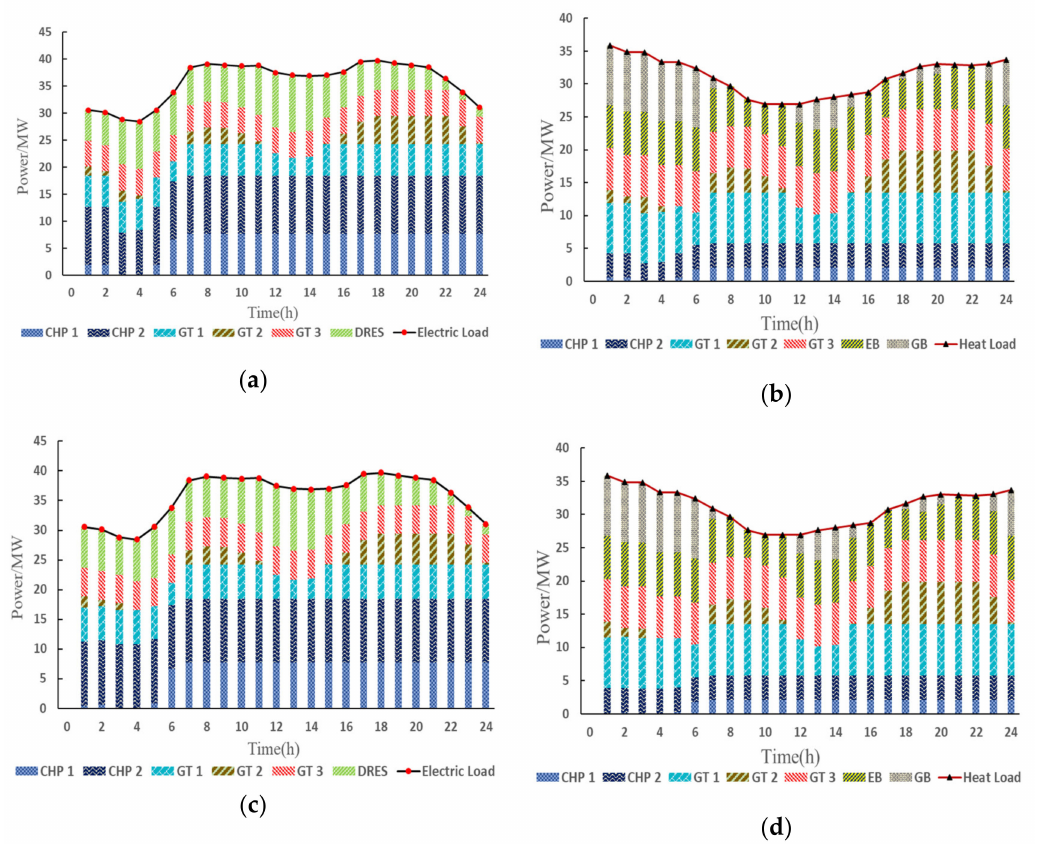
Figure 6. A comparison chart of the day ahead market operation scheme before and after gas price adjustment: ( a ) Electricity supply mix considering price adjustment; ( b ) heat supply mix considering price adjustment; ( c ) electricity supply mix without considering price adjustment; ( d ) heat supply mix without considering price adjustment.